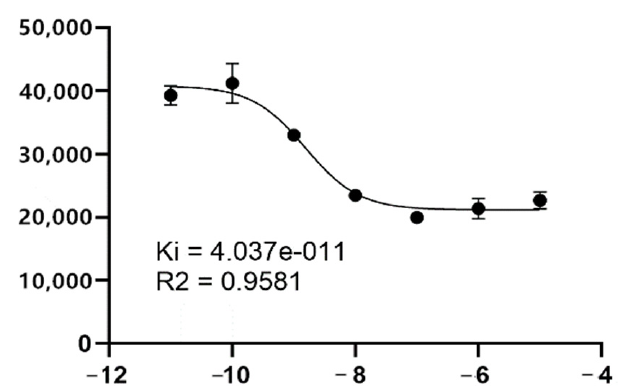
Figure 5. The Ki value of PSMA.